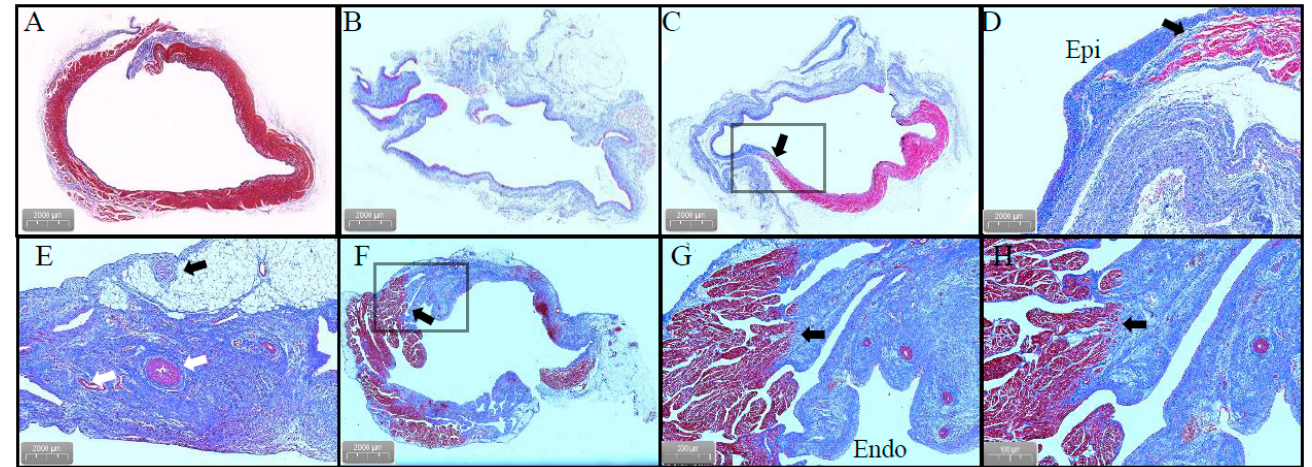
Figure 8. Masson’s trichrome stain. ( A ) Normal PVs tissue. ( B ) Transmural damage to the RSPV tissue caused by PFA without stenosis. ( C , D ) The arrows point to transmural cardiomyocyte loss and an area with a relatively unaffected myocardium. ( E ) White: vascular structure; black: nerve tissue. ( F ) Transmural damage to the SVC caused by PFA. ( G , H ) The arrows point to transmural cardiomyocyte loss and an area with a relatively unaffected myocardium. Abbreviations: Epi, epicardial; Endo, endocardial.